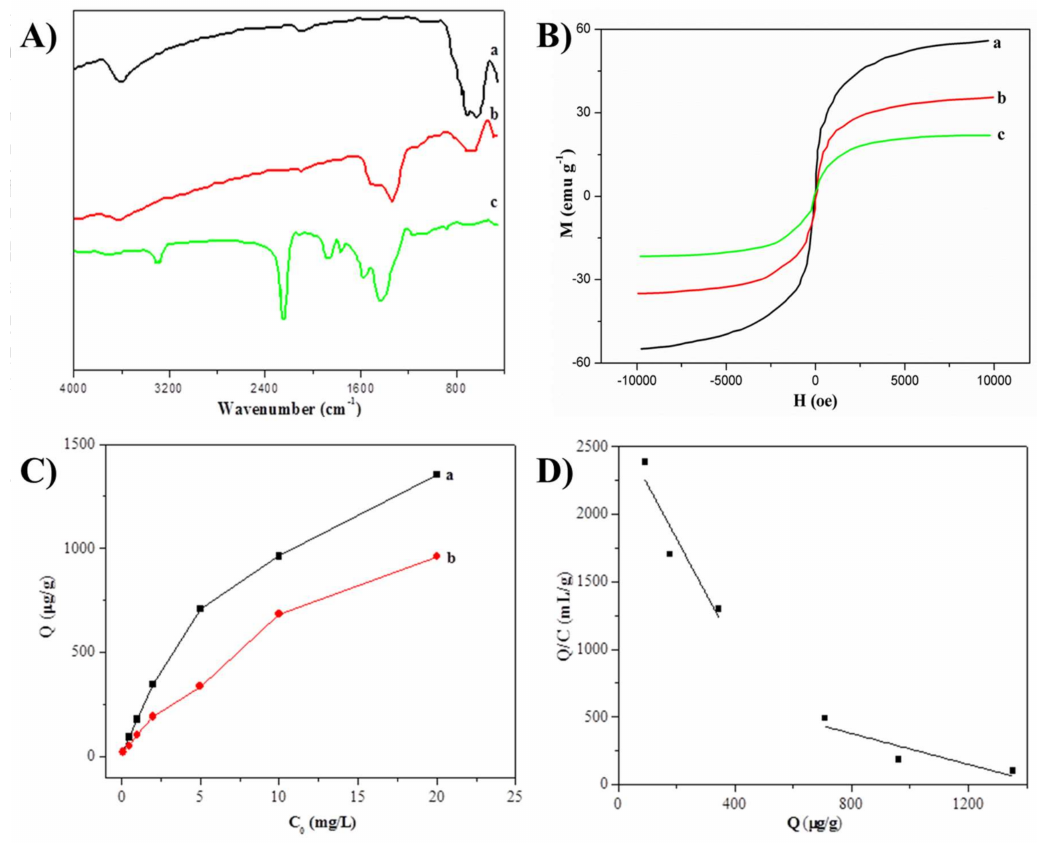
Figure 4. ( A ) FT-IR spectra of Fe 3 O 4 (a), Fe 3 O 4 @SiO 2 (b) and MDMIPs (c); ( B ) Magnetization curves for Fe 3 O 4 (a), Fe 3 O 4 @SiO 2 (b), and MDMIPs (c); ( C ) Melamine adsorption isotherms of MDMIPs (a)